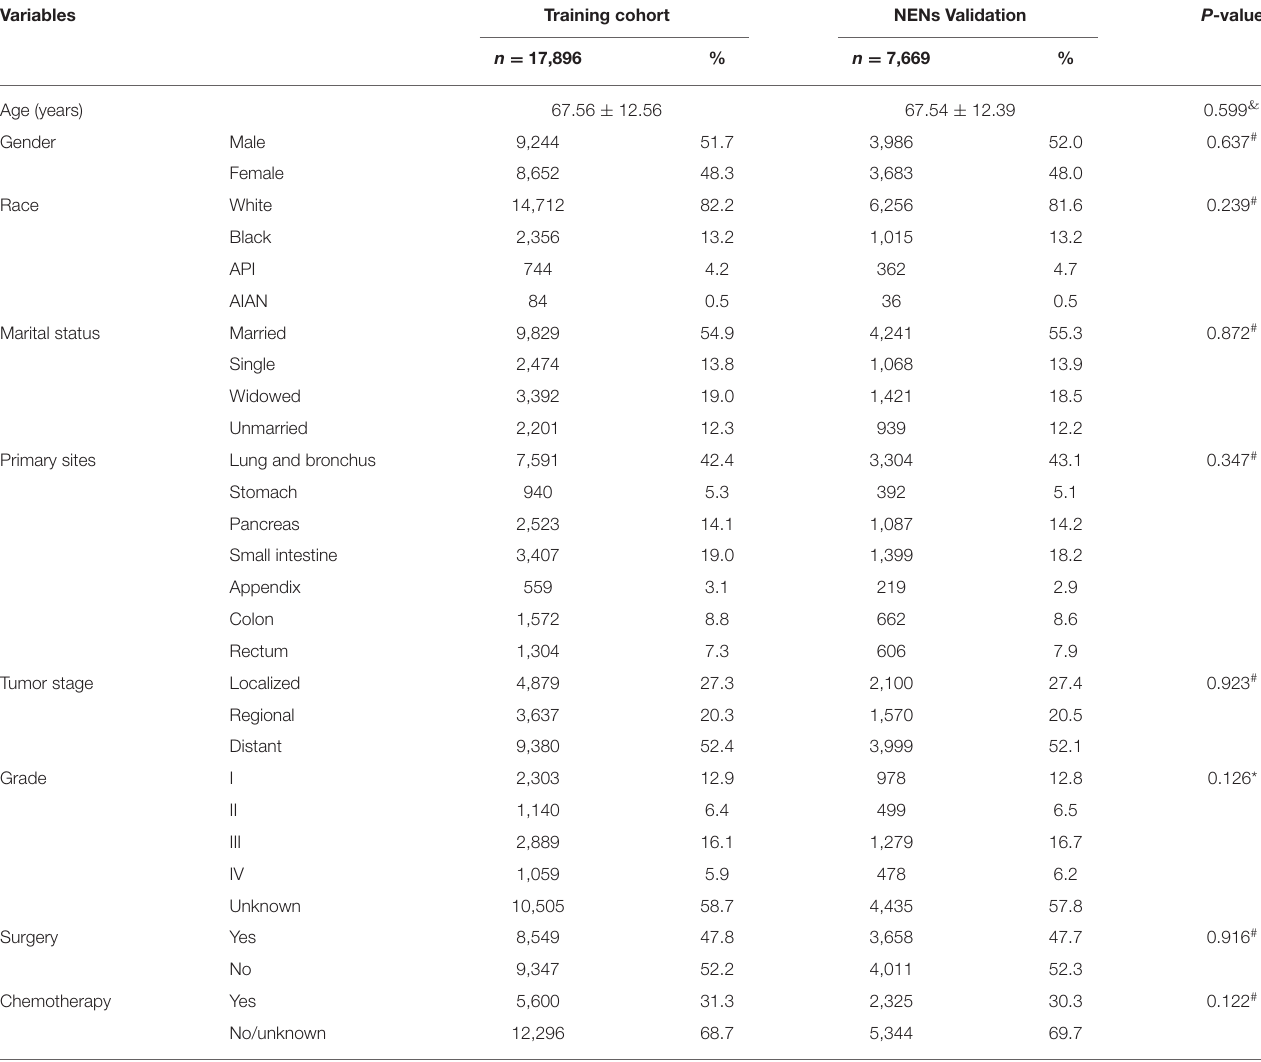
TABLE 2 | Basic characteristics of patients in the training data set and the validation data